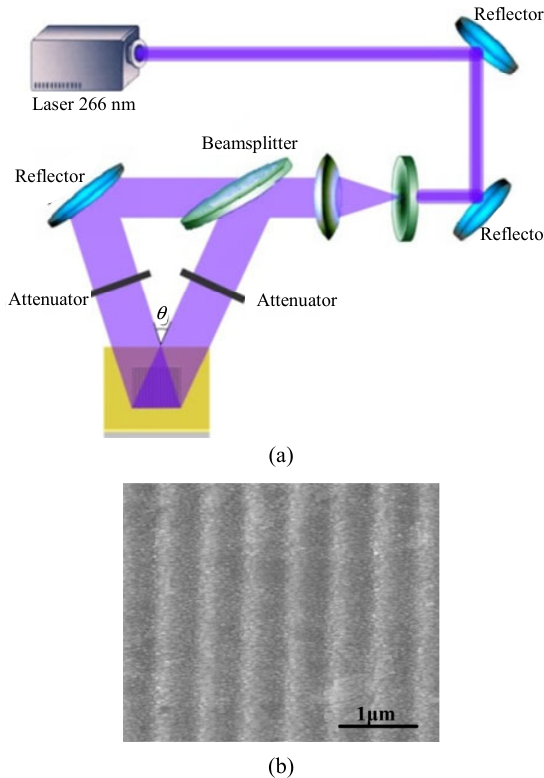
Fig. 8 Preparation of the 1D sinusoidal Ag nanograting: (a) schematic illustration of two-beam interference fabrication of the 1D sinusoidal nanograting and (b) the scanning electron microscopy (SEM) image of the 1D sinusoidal Ag